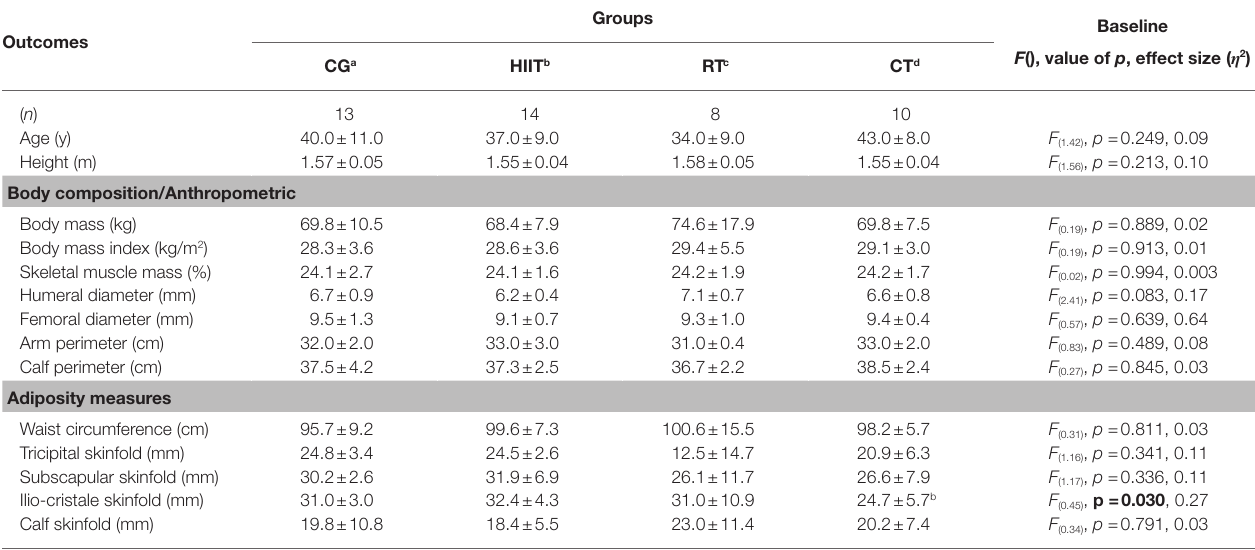
TABLE 1 | Baseline characteristics of the study cohort assigned to the exercise or control groups.